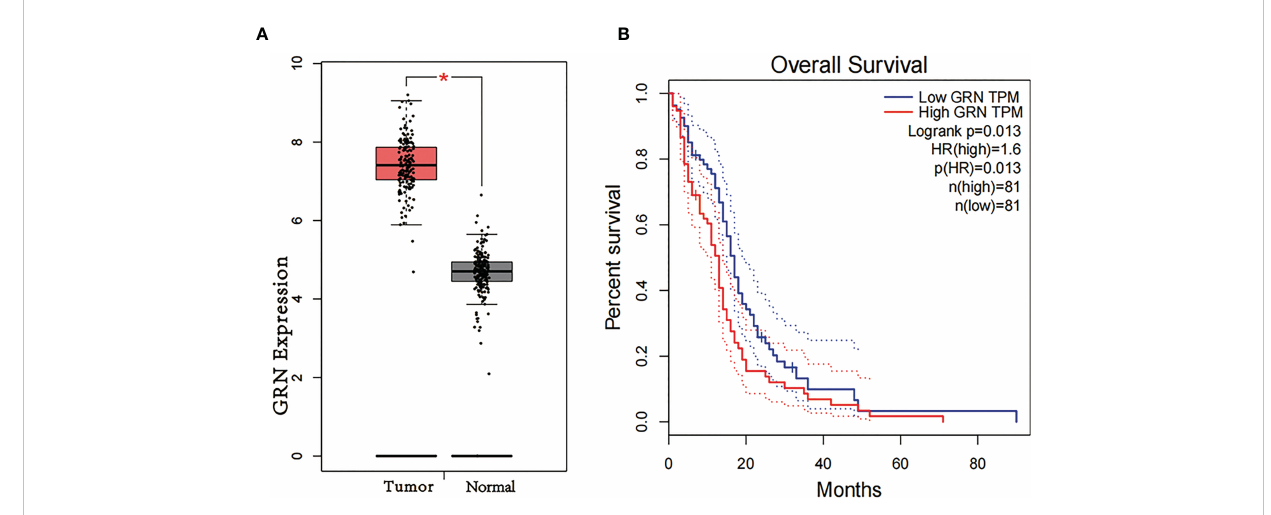
FIGURE 1 (A) Differential expression of GRN in different disease state (Tumor or Normal). (B) Survival curve of differential GRN expression were analyzed by GEPIA. *P <